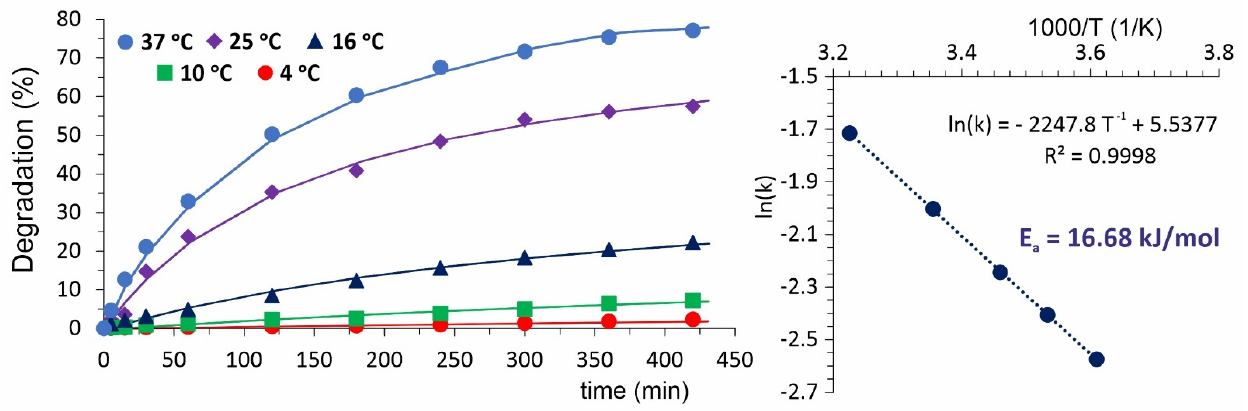
Figure 2. Influence of temperature on PPF degradation kinetics.